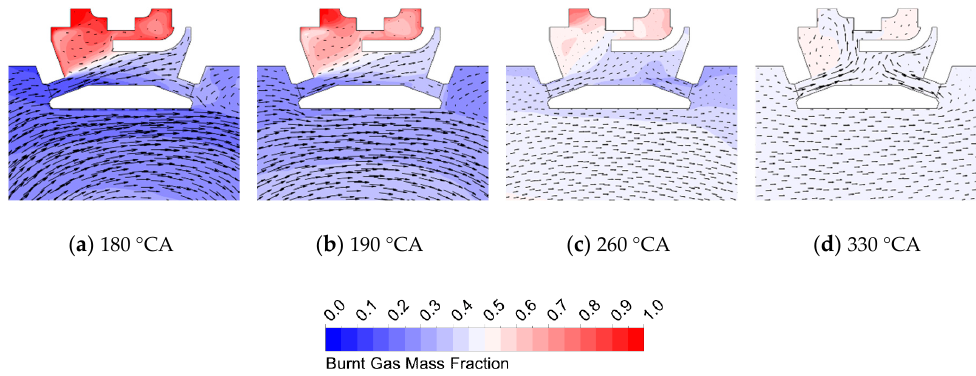
Figure 12. Scavenging behavior at 2500 rpm and 10% of load inside the PN8 prechamber.